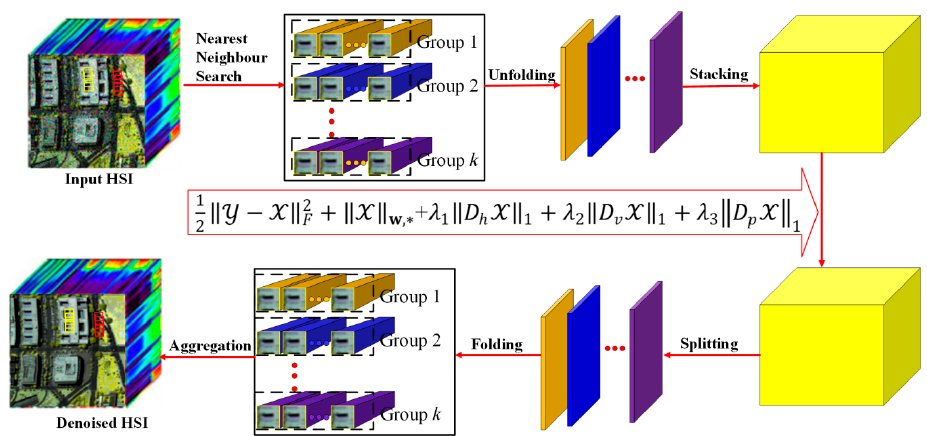
Figure 1. The flowchart of the proposed method. Table 1. The main mathematical symbols used in the paper and their corresponding explanations.